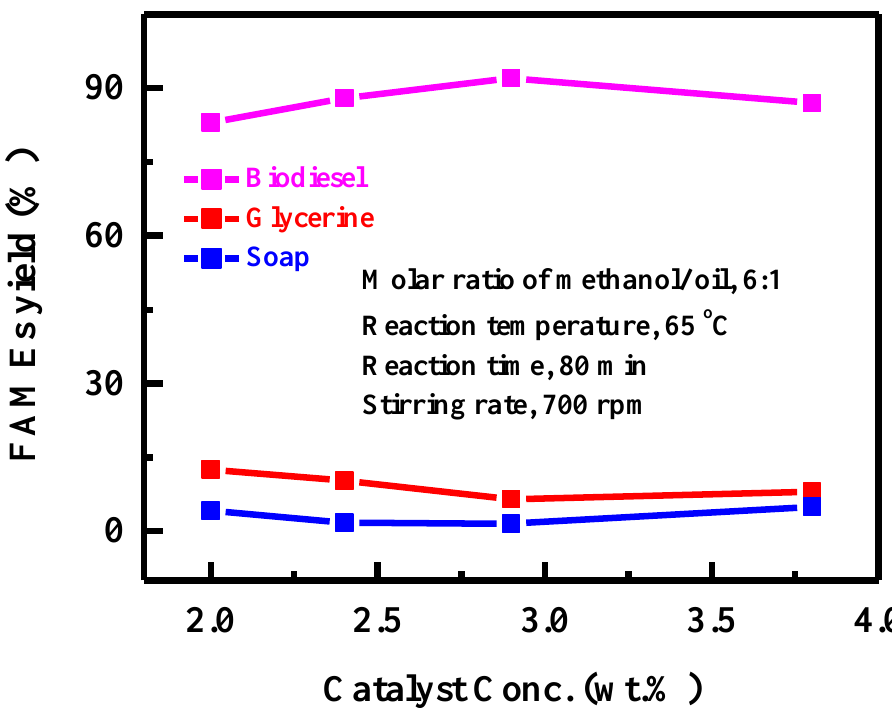
Figure 5. The e ff ect of catalyst concentration on RTOB Figure 5. The effect of catalyst concentration on RTOB yield.